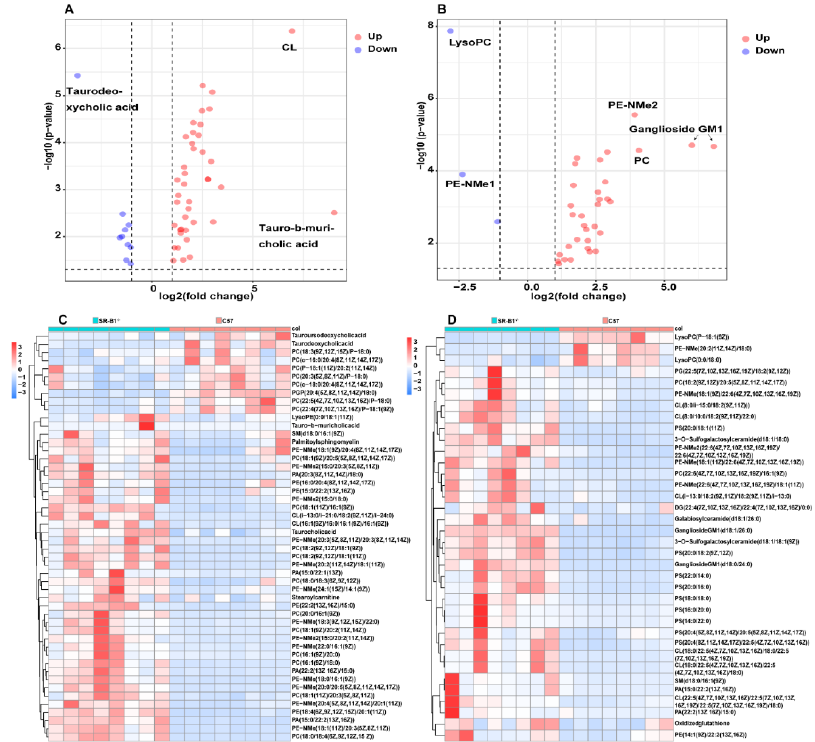
Figure 3. The differential metabolites in the small intestine ( A , C ) and large intestine ( B , D ) of the C57 and SR − B1 − / − mice; p < 0.05, fold change >2, and variable importance in projection (VIP) >1. The KEGG metabolic pathway analysis showed that glycerophospholipid metabo ‐ lism and linoleic acid metabolism were obviously different in both the small intestine and large intestine in the SR − B1 − / − mice compared with those in the C57 mice ( p < 0.05), while taurine and hypotaurine metabolism were obviously different in the small intestine ( p < 0.05), and the sphingolipid metabolism was obviously different in the large intestine ( p < 0.05, Figure 4A,B). The metabolic pathways of the glycerophospholipid metabolism and sphingolipid metabolism were closely related to glycine (GLY), threonine (THR), and ser ‐ ine (SER) metabolism, and the metabolism of taurine (TAU) and hypotaurine were closely related to alanine (ALA), TAU, and methionine (MET) metabolism. The metabolite en ‐ richment analysis showed that glycerophosphoethanolamines, glycerophosphocholines, TAU conjugates, ceramide phosphocholines, and others were significantly enriched in the small intestine and that diacylglycerophosphoserines, glycosphingolipids, phos ‐ phosphingolipids, and others were significantly enriched in the large intestine (Figure 4C,D).